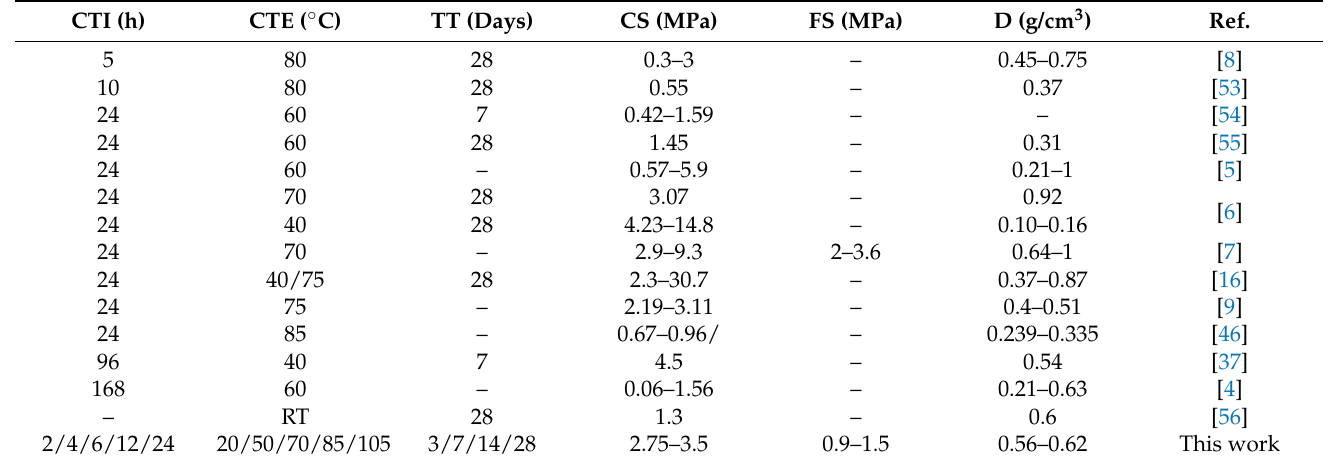
Table 2. The condition and mechanical properties of GF from this work and literature.